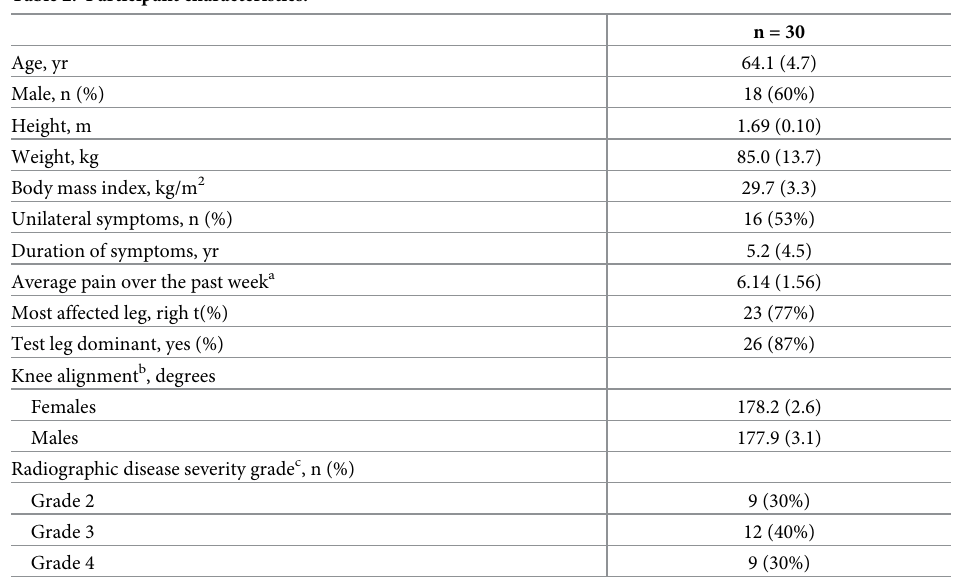
Table 2. Participant characteristics.